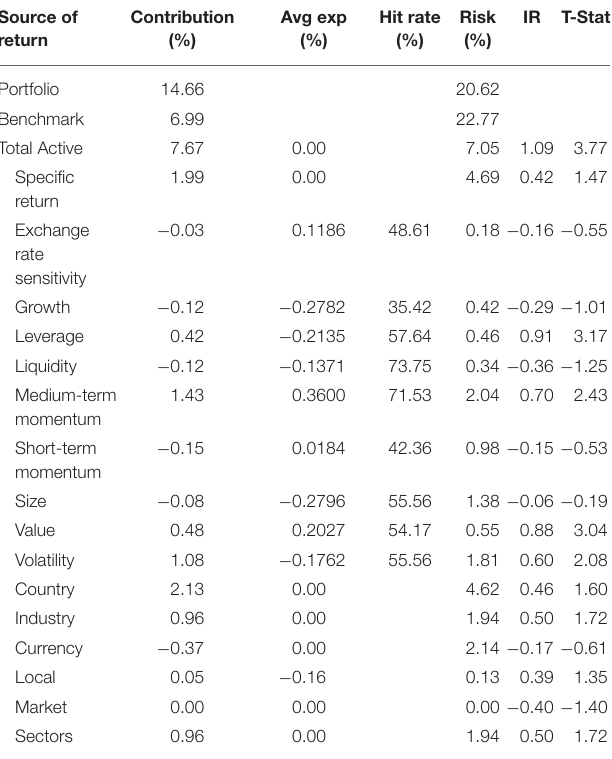
TABLE 3 | Axioma attribution of Mean-ETL-MQ (XUS) portfolio. TABLE 4 | Axioma attribution of Mean-ETL-MQ (EM) portfolio.